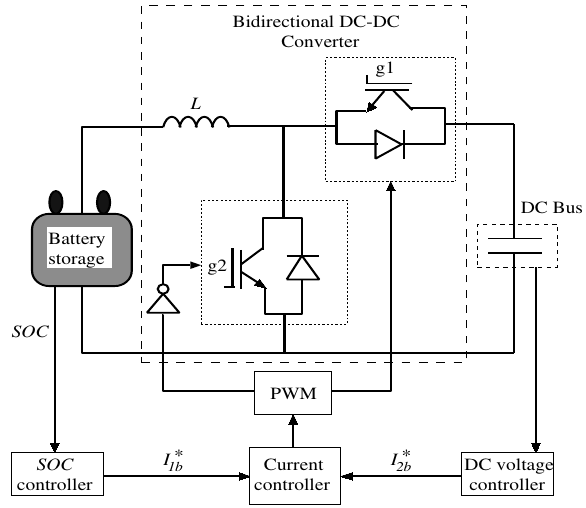
Figure 6. Control system of the battery and DC–DC chopper.